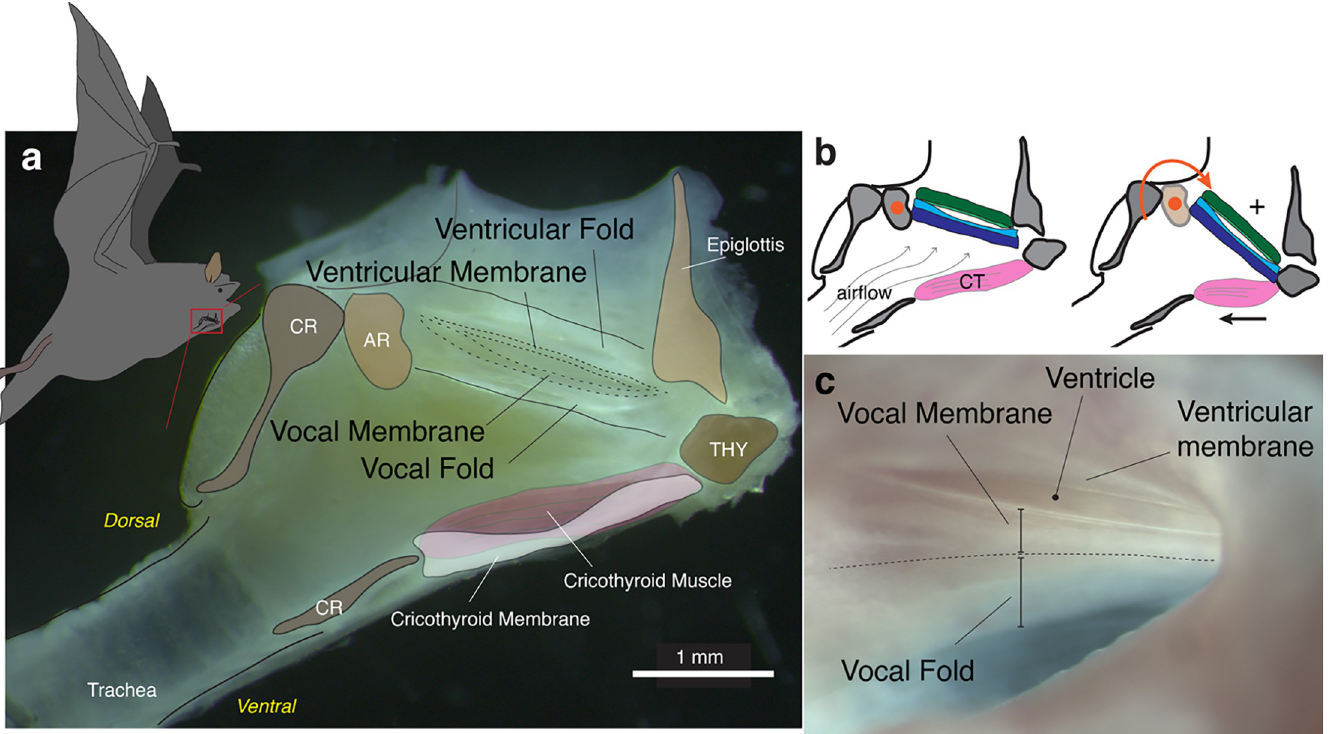
Fig 1. Specialized anatomy of the microchiropteran bat larynx. (a) Sagittal cross-section of the larynx of M . daubentonii . The paired vocal and ventricular folds with apical membranes are suspended between arytenoids and thyroid. (b) The mechanism of sound production is hypothesized to be airflow-induced vibration of the vocal membranes (left). Contraction of the cricothyroid muscle rotates the thyroid around the cricoarytenoid joint (right) and thereby elongates and increases tension in the vocal folds and membranes (+), which in turn increases the f . (c) Detail of left ventricular and vocal folds with thin apical membranes. AR, arythenoid; CR, cricoid; o THY, thyroid